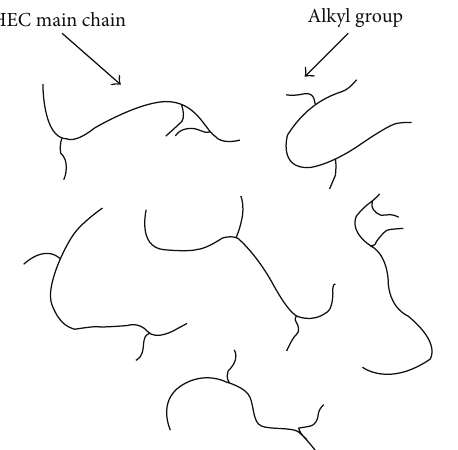
Figure 5: Illustration of HMHEC in aqueous solution.